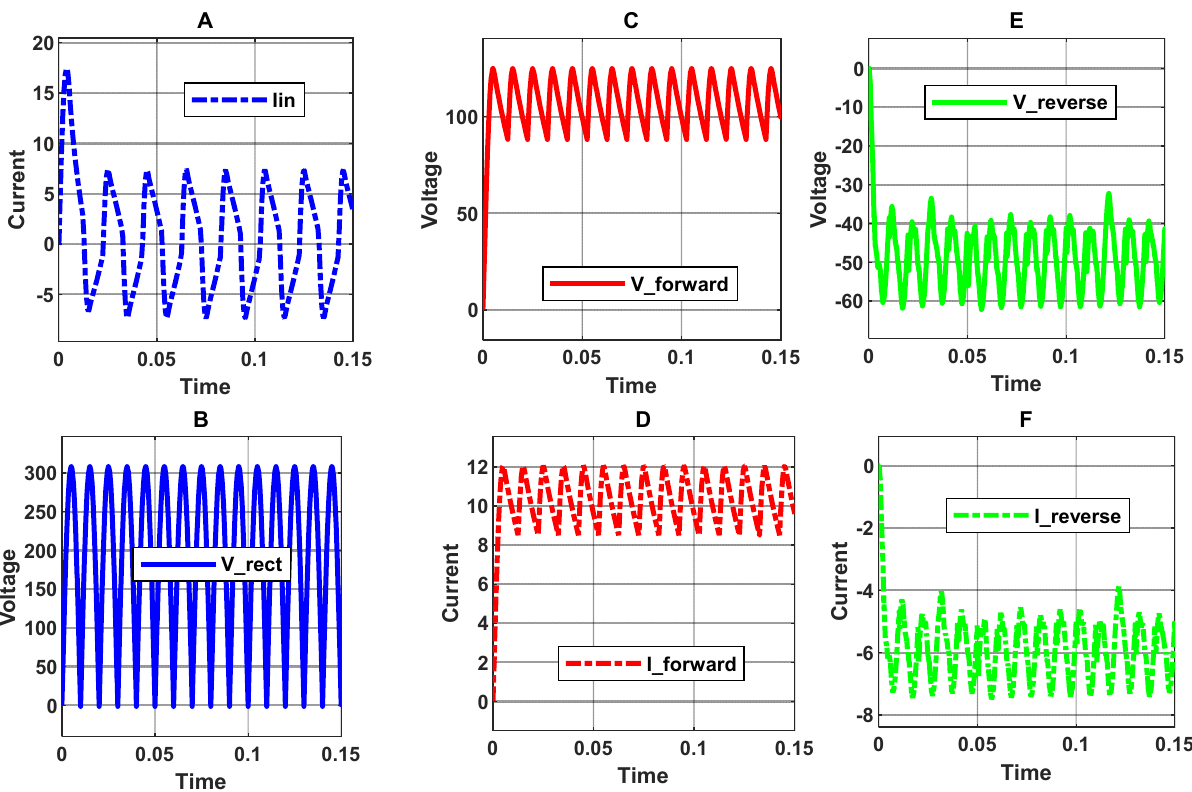
Figure 13. Waveforms when the input voltage is 220 V rms . ( A ) line current, ( B ) rectified voltage ( C ) forward voltage, ( D ) forward current, ( E ) reverse voltage, ( F ) reverse current